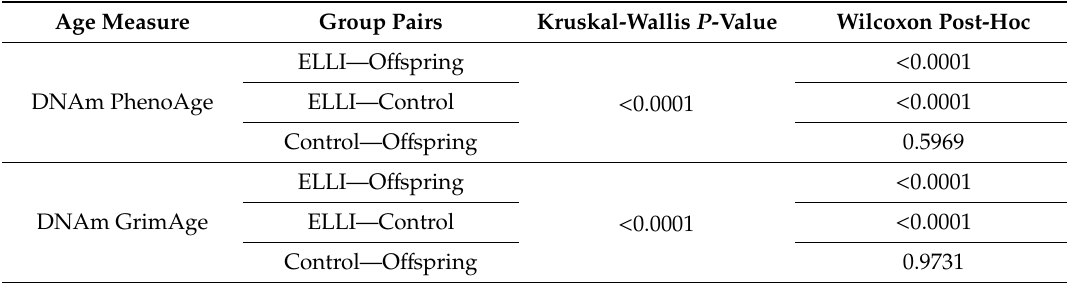
Table A3. One-way analysis of each age measurement through groups.